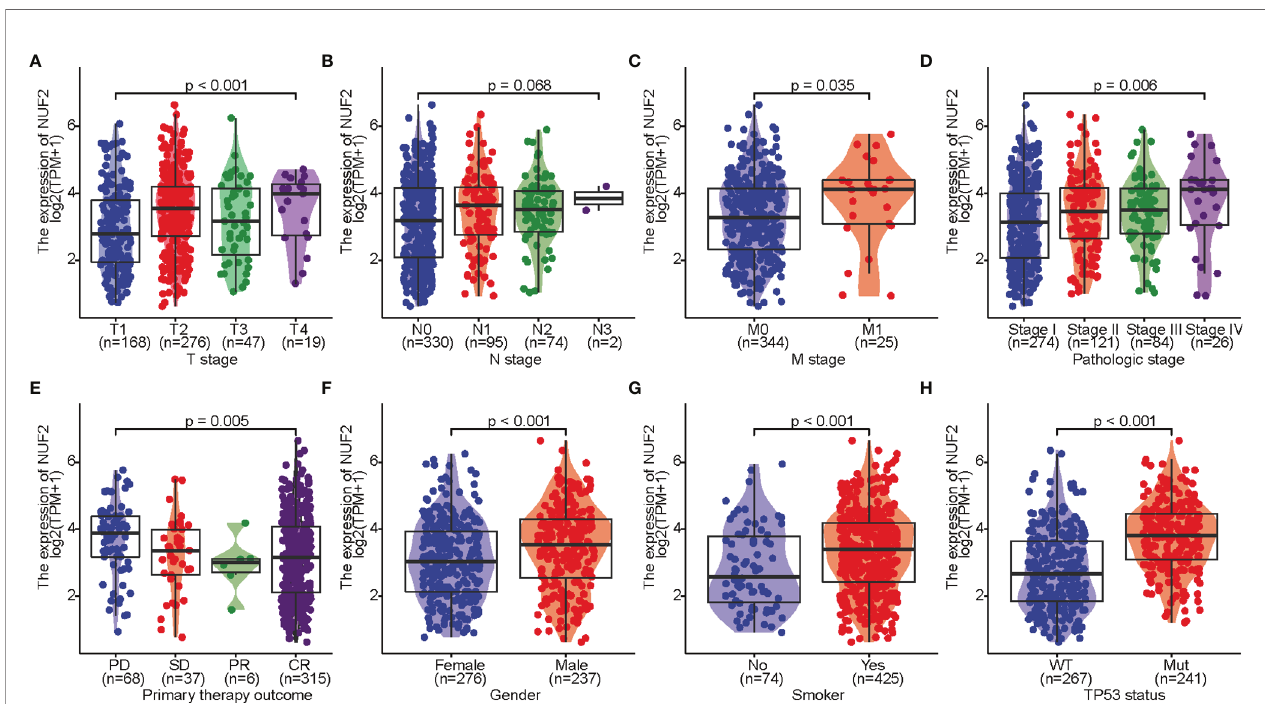
FIGURE 3 | Correlation of NUF2 expression of and clinicopathologic variables. (A) T stage, (B) N stage, (C) M stage. (D) pathologic stage. (E) primary therapy outcome, (F) sex, (G) smoking. (H) TP53 status.